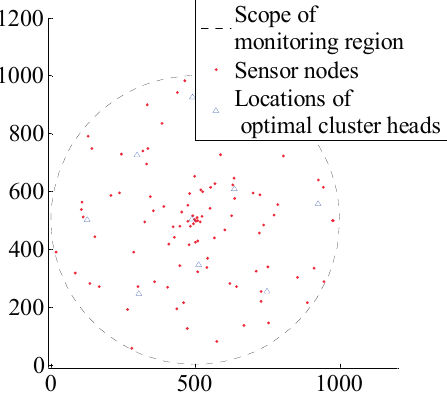
Figure 2. Distribution of optimal cluster heads when c = 9, N = 100.